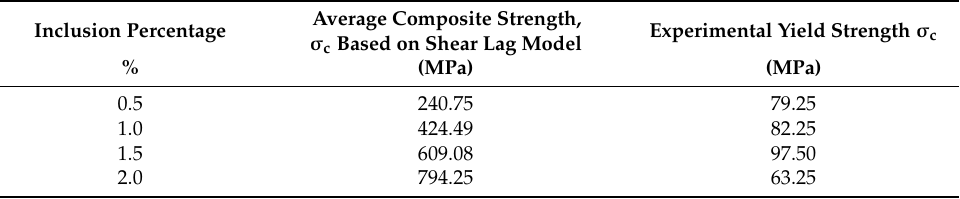
Table 5. Calculated and experimental strength of